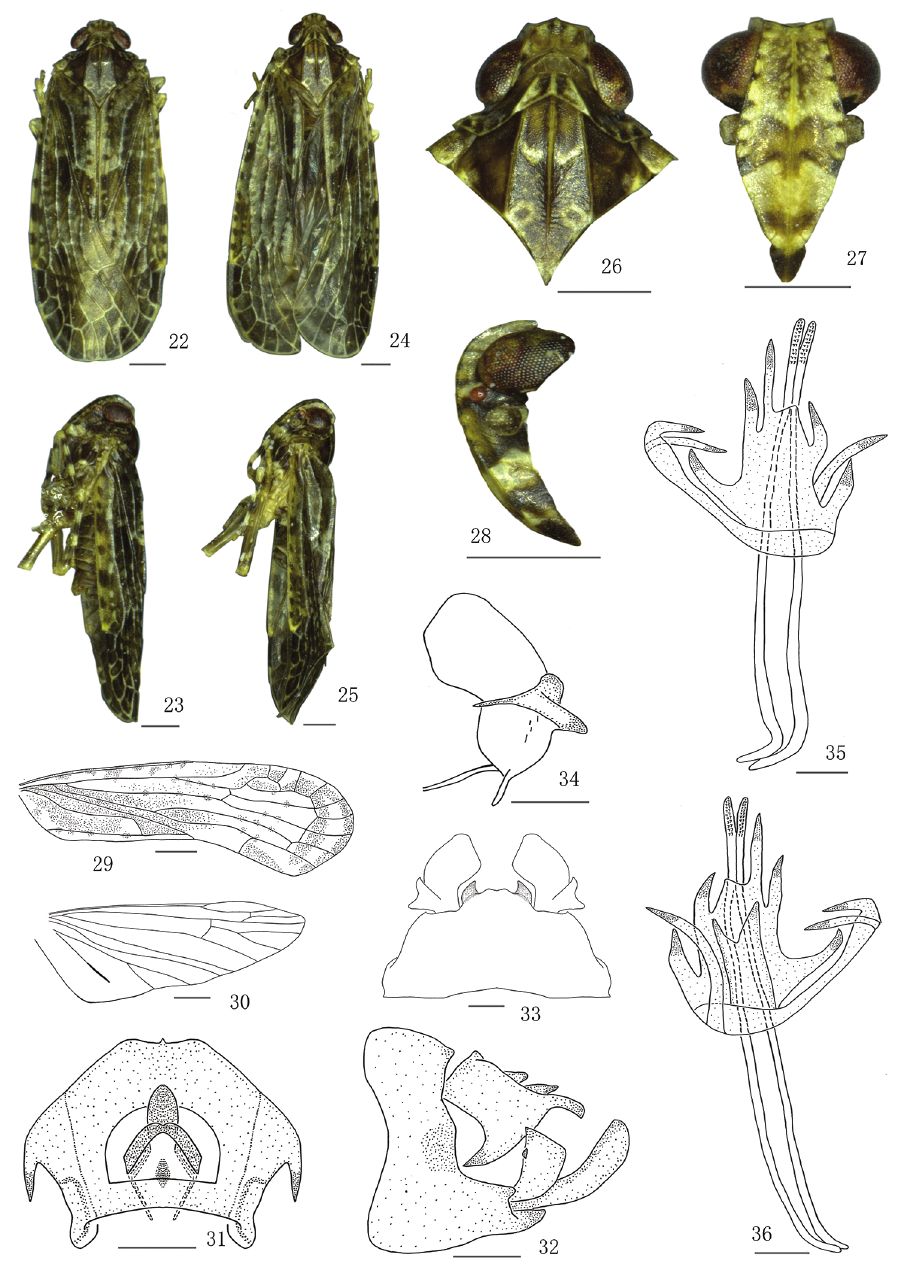
Figures 22–36. Magadhaideus pingbianensis sp. n. 22–23 Male habitus (dorsal and lateral views) 24–25 Female habitus (dorsal and lateral views) 26 Head and thorax, dorsal view 27 Face 28 Head, lateral view 29 Forewing 30 Hindwing 31 Anal segment of male, dorsal view 32 Male genitalia, lateral view 33 Male genitalia, ventral view 34 Left genital style, dorsal view 35 Aedeagus dorsal view, 36 Aedeagus ventral view. Scale bars: 0.2 mm ( 29–34 ); 0.5 mm ( 26–28, 35–36